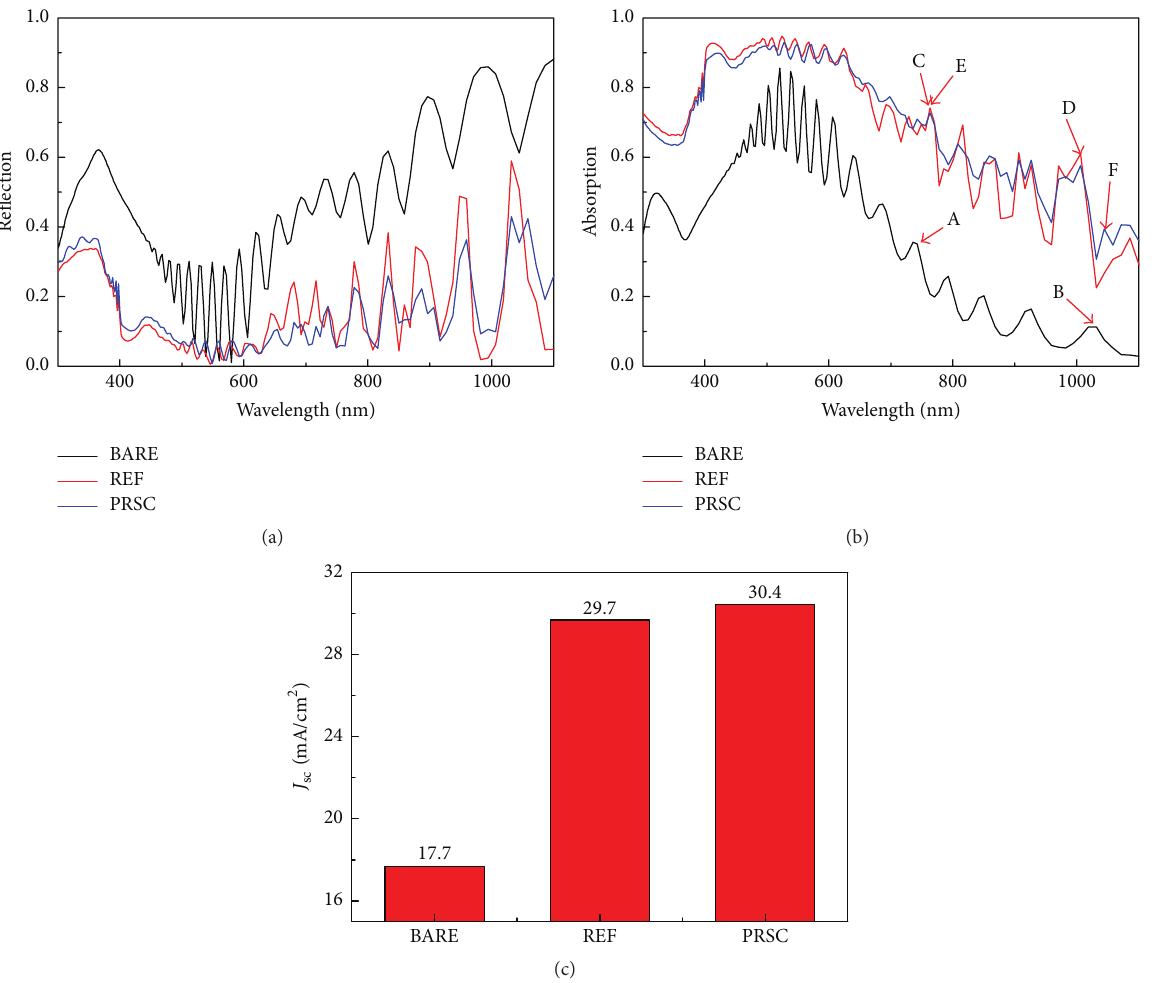
Figure 2: The reflection (a), the absorption (b), and the short circuit current density (c) of the BARE cell, the REF cell, and the PRSC with random position of the grating